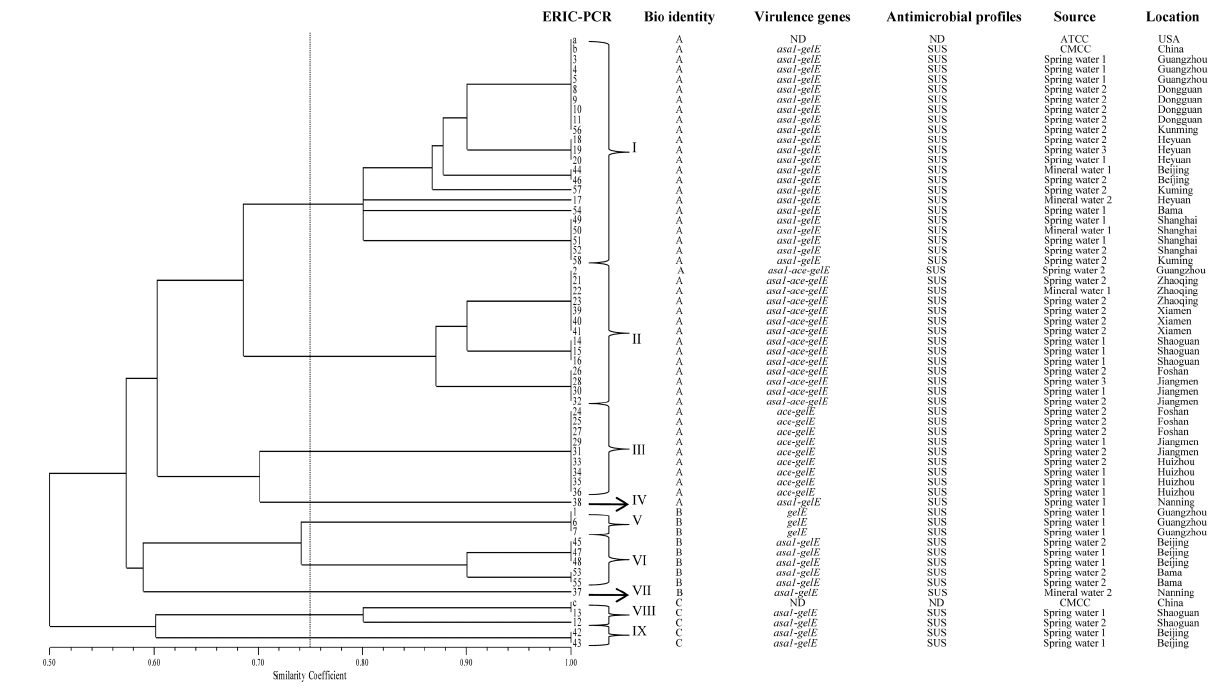
FIGURE 2 | ERIC-PCR DNA fingerprint analysis of E. faecalis isolates from mineral water and spring water in China. a, b and c represent E. faecalis ATCC 29212, CMCC 32219 and CMCC 32223, respectively; ND, not detect; SUS, susceptibility; 1, 2 and 3 represent source water, activated carbon filtered water and finish product,